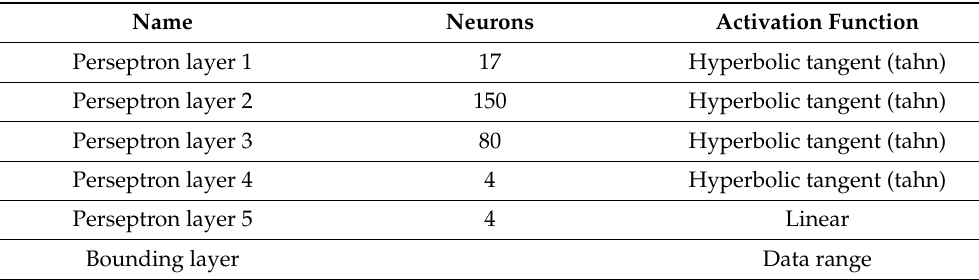
Table 4. Parameters of neural network.